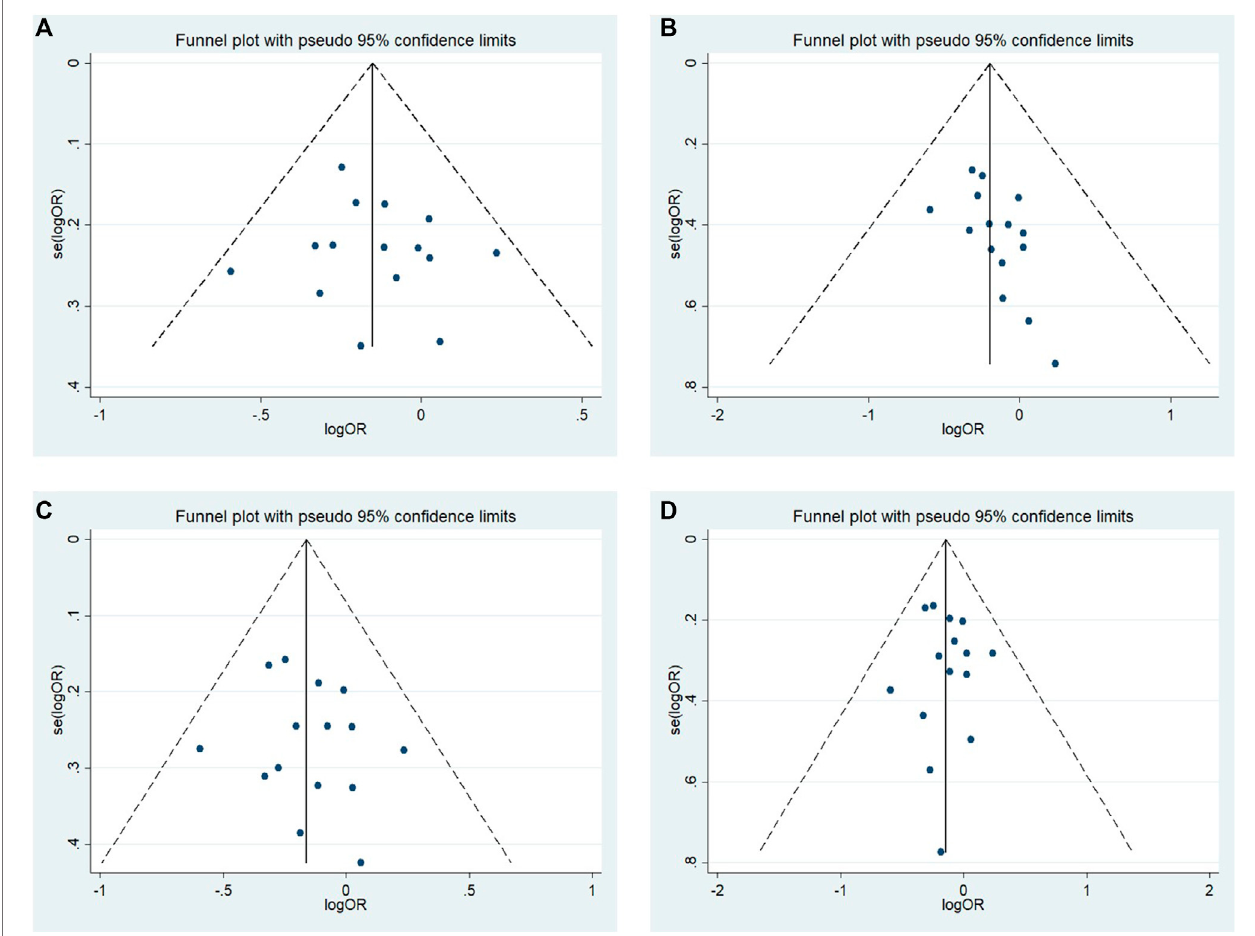
FIGURE4| Funnelplotoftheoddsratiosinthemeta-analysis. (A) Allelemodel,10Rvs.allothers (B) Pseudodominantmodel,10R/10R+10R/9Rvs.allothers (C) Pseudorecessive model, 10R/10R vs. all others (D) Pseudocodominant model, 10R/9R vs. all others OR: odds ratio, CI: con fi dence interval, I-squared: measured to quantify the degree of heterogeneity in